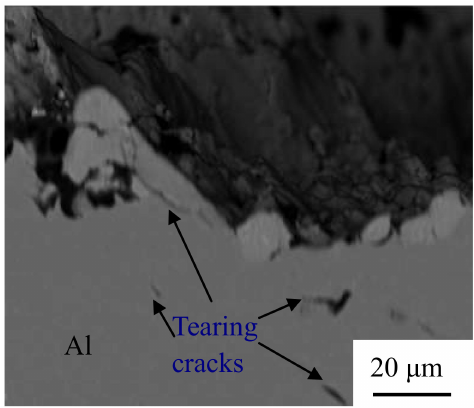
Figure 12. Fracture morphology of the Al/Al joints with different interlayer thicknesses, ( a ) without an interlayer, ( c ) 10 µ m, ( b , d ) showing the magnified areas in ( a , c ), respectively, ( e ) 30 µ m, ( f ) 60 µ m, and ( g ) 80 µ m.